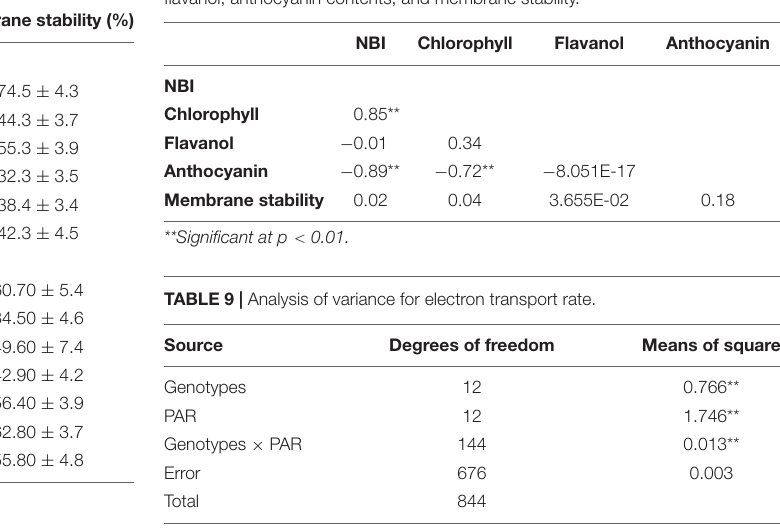
Frontiers in Plant Science |